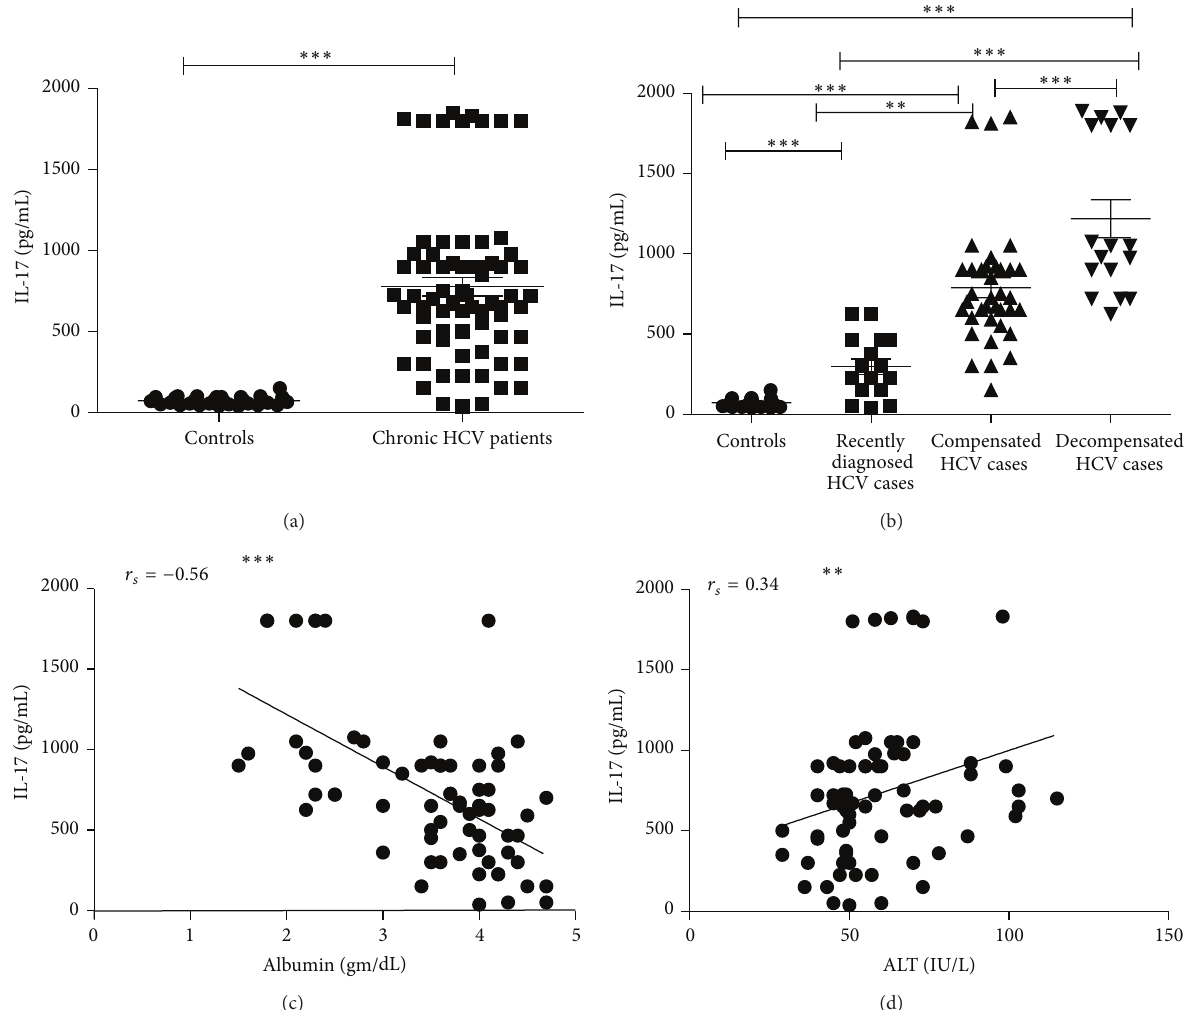
Figure 1: Serum IL-17 comparative results from chronic HCV patients and uninfected controls (a) and comparison between patients subgroups and controls (b). ∗ indicates 𝑃 < 0.05 ; ∗∗ indicates 𝑃 < 0.01 ; and ∗ ∗ ∗ indicates 𝑃 < 0.001 . IL-17 correlation with Albumin (c) and ALT (d). Spearman coefficients were determined ( 𝑟 𝑠 = −0.56 for Albumin; and 𝑟 𝑠 = 0.34 for